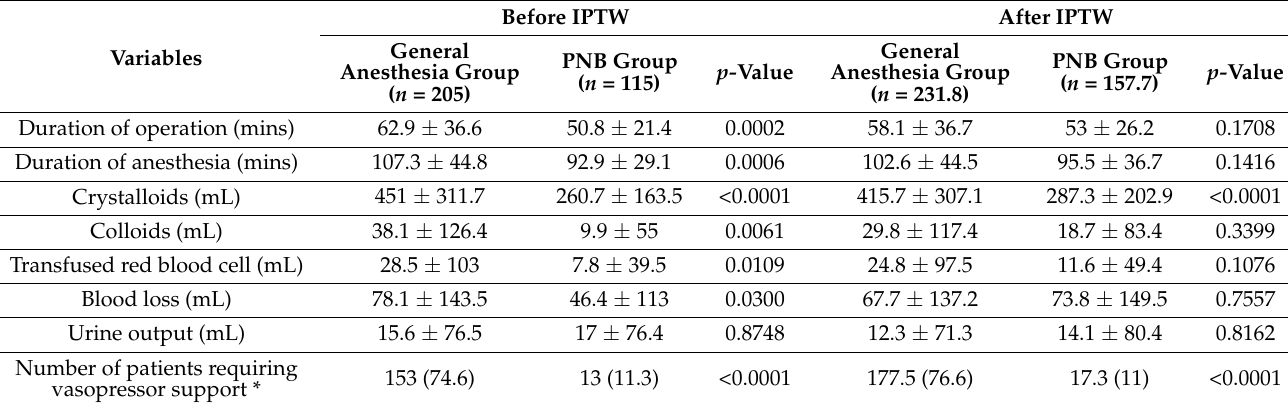
Table 2. Intraoperative